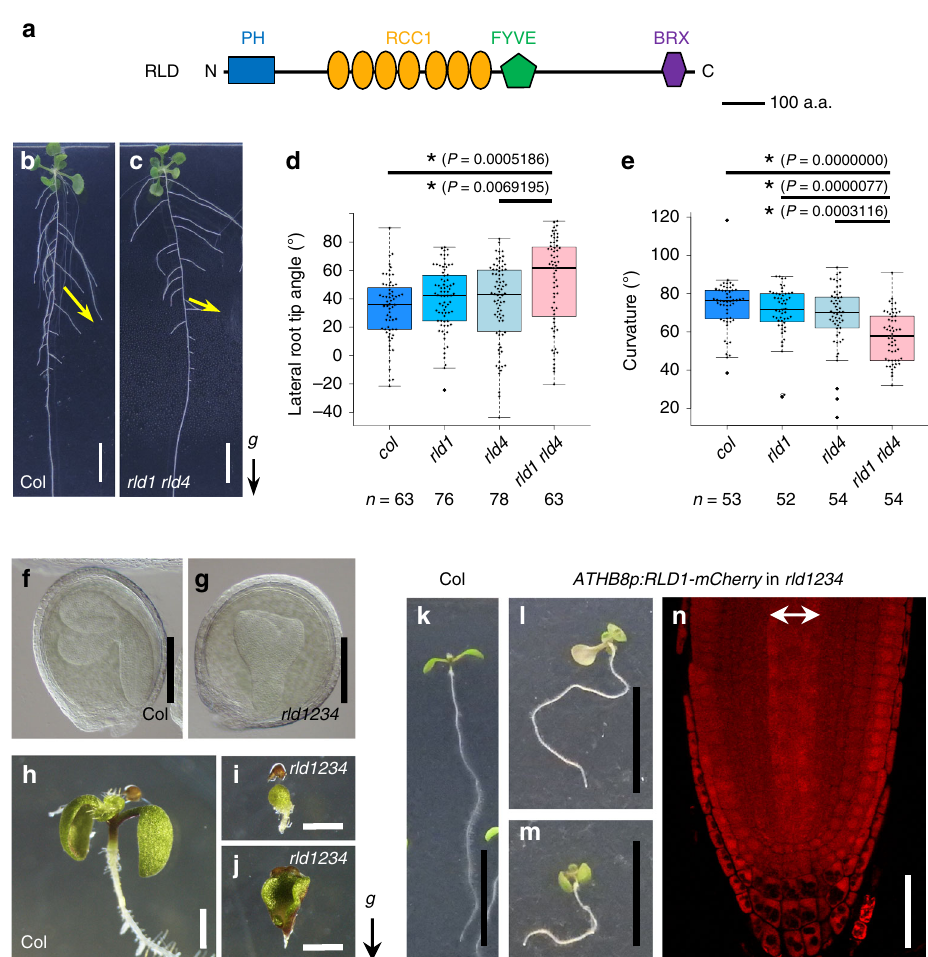
Fig. 1 RLD genes regulate GSA in LRs and embryo development. a Schematic diagram of RLD. b , c Twelve-day-old seedlings of Col ( b ) and rld1-2 rld4-1 double mutant ( c ). Arrows indicate the growth orientation of lateral roots. d Lateral root tip angle is represented by boxplots for 12-day-old seedlings of Col, rld1-2 , rld4-1 , and rld1-2 rld4-1 toward the direction of gravity. Median and quartile values are provided by the central line and box boundaries. Whiskers show min to max values. n , sample number of three biologically independent experiments. Asterisks indicate signi fi cant differences by the Tukey – Kramer method ( P < 0.05). e Comparison of root curvature of 5-day-old seedlings of each line at 12 h after a 90° reorientation. n , sample number of three biologically independent experiments. Asterisks show signi fi cant differences by the Tukey – Kramer method ( P < 0.05). f , g Embryos of Col ( f ) and rld1-2 rld2-2 rld3-2 rld4-1 ( g ). h – j Seven-day-old seedlings of Col ( h ) and rld1-2 rld2-2 rld3-2 rld4-1 ( i , j ). k – m Seven-day-old seedlings of Col ( k ) and